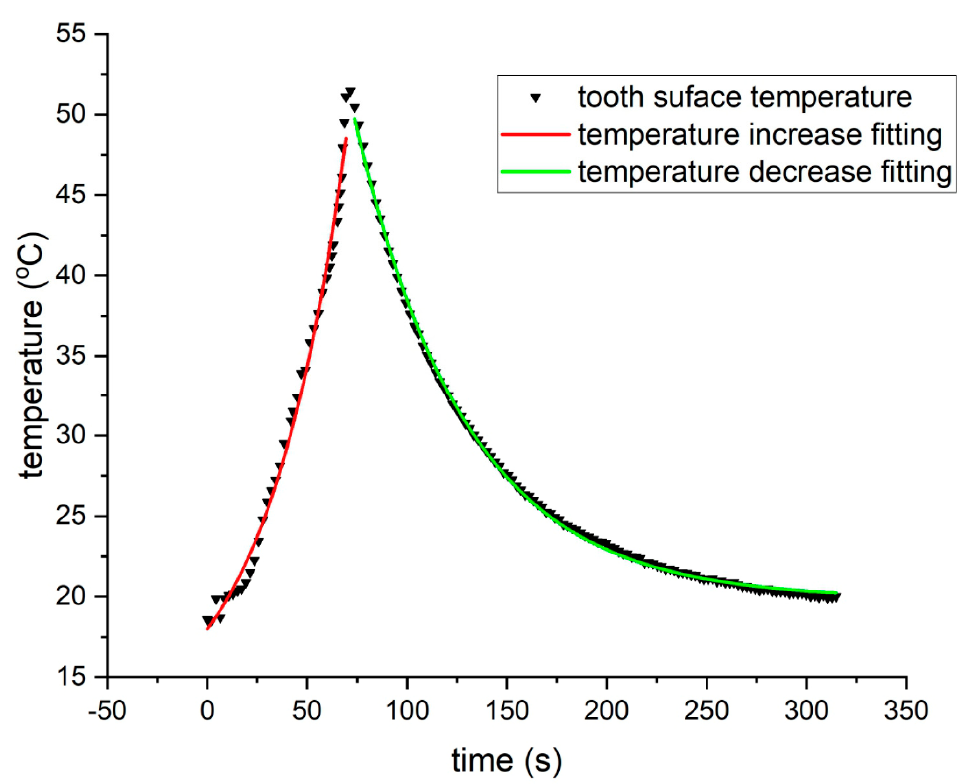
Figure 2. An example of the relationship between the premolar pulp chamber temperature (T) and the time (t) of polishing for a procedure performed without water cooling. time (t) of polishing for a procedure performed without water